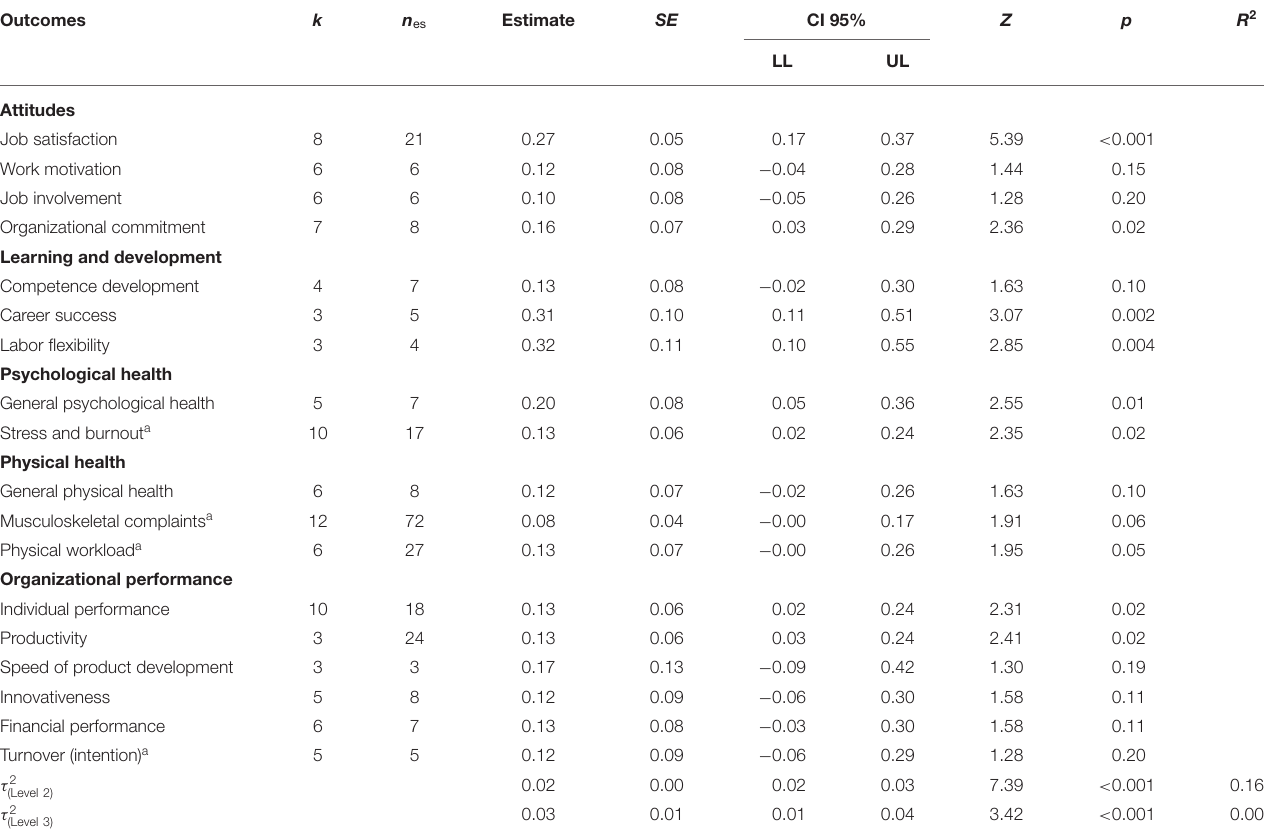
TABLE 1 | Relationships between job and task rotation and outcomes. Outcomes k n es Estimate SE CI 95% Z p R 2